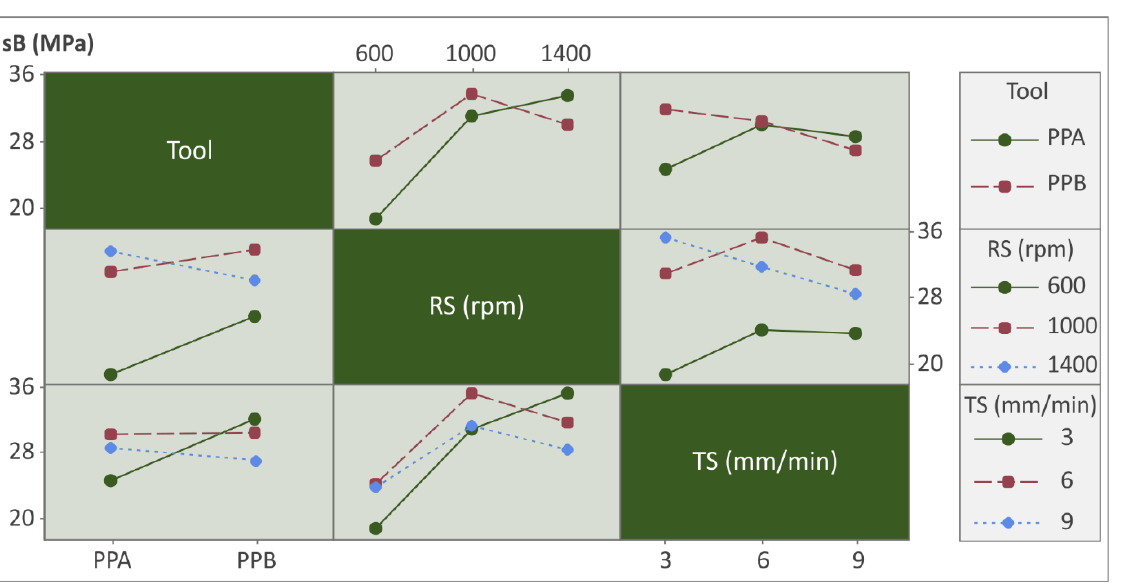
Figure 13. Interaction chart: Tool, RS, and TS vs. sB.